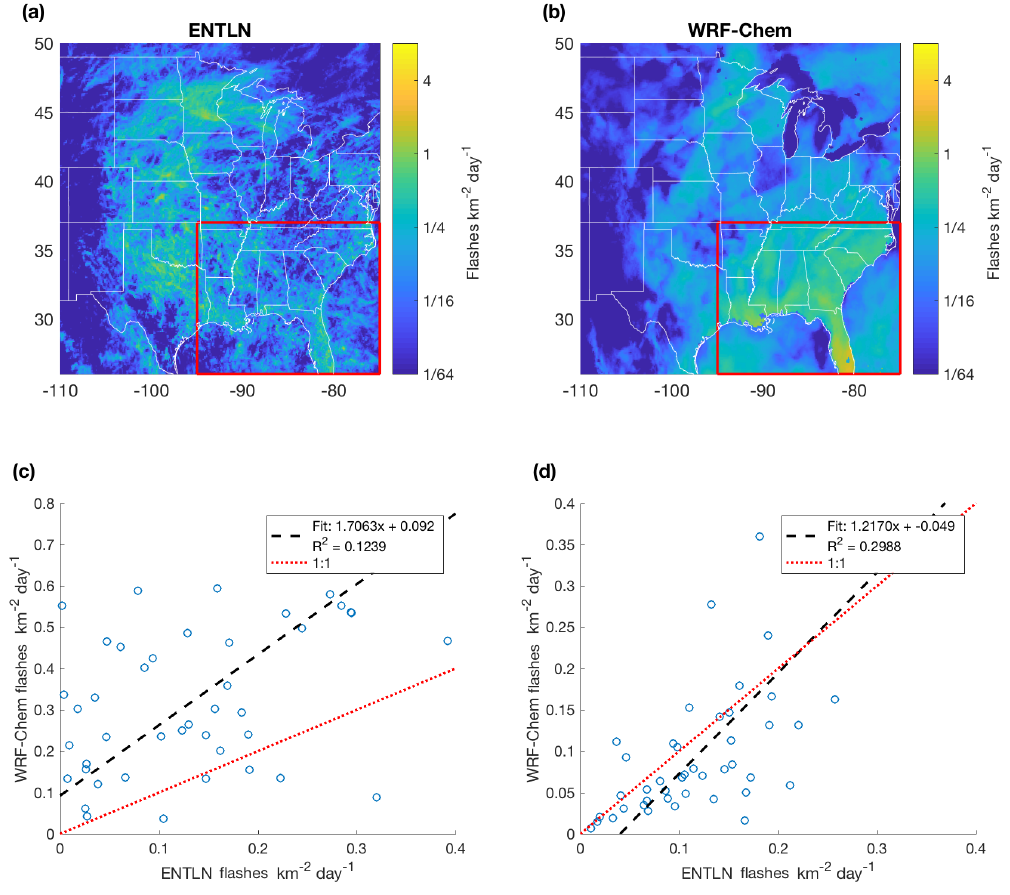
Figure 2. Comparison between observed and simulated flash density from 13 May to 23 June 2012. Panels (a) and (b) show the mean flash density averaged over the study period from ENTLN and WRF-Chem, respectively. Both are gridded at 12km grid spacing. Panels (c) and (d) show the correlation between total flash density per day between WRF and ENTLN in (c) the southeast US (denoted by the red box in a and b ) and (d) elsewhere in the contiguous